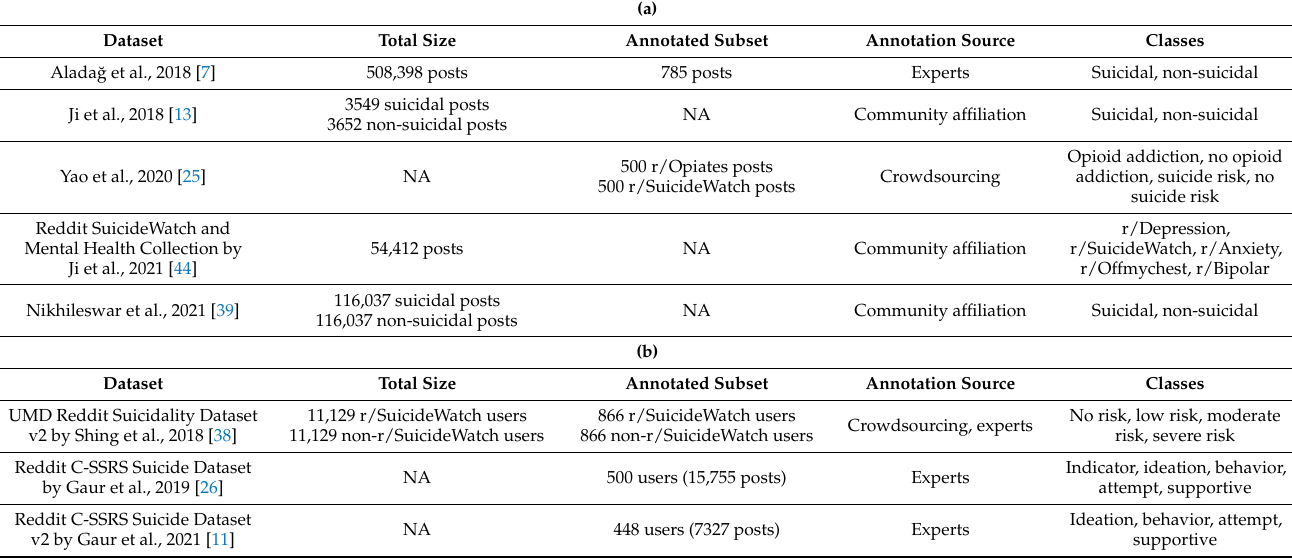
Table 1. Data source: ( a ) post level and ( b ) user